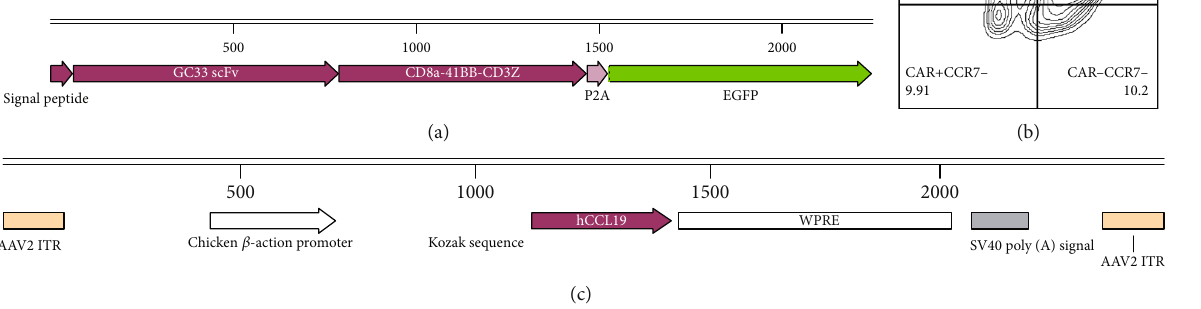
Figure 1: CAR-T and AAV vector characteristics. (a) Schematic diagram of the structure of CAR gene; (b) fl ow analysis of the CAR-T cell phenotype; (c) schematic diagram of the AAV-CCL19 vector